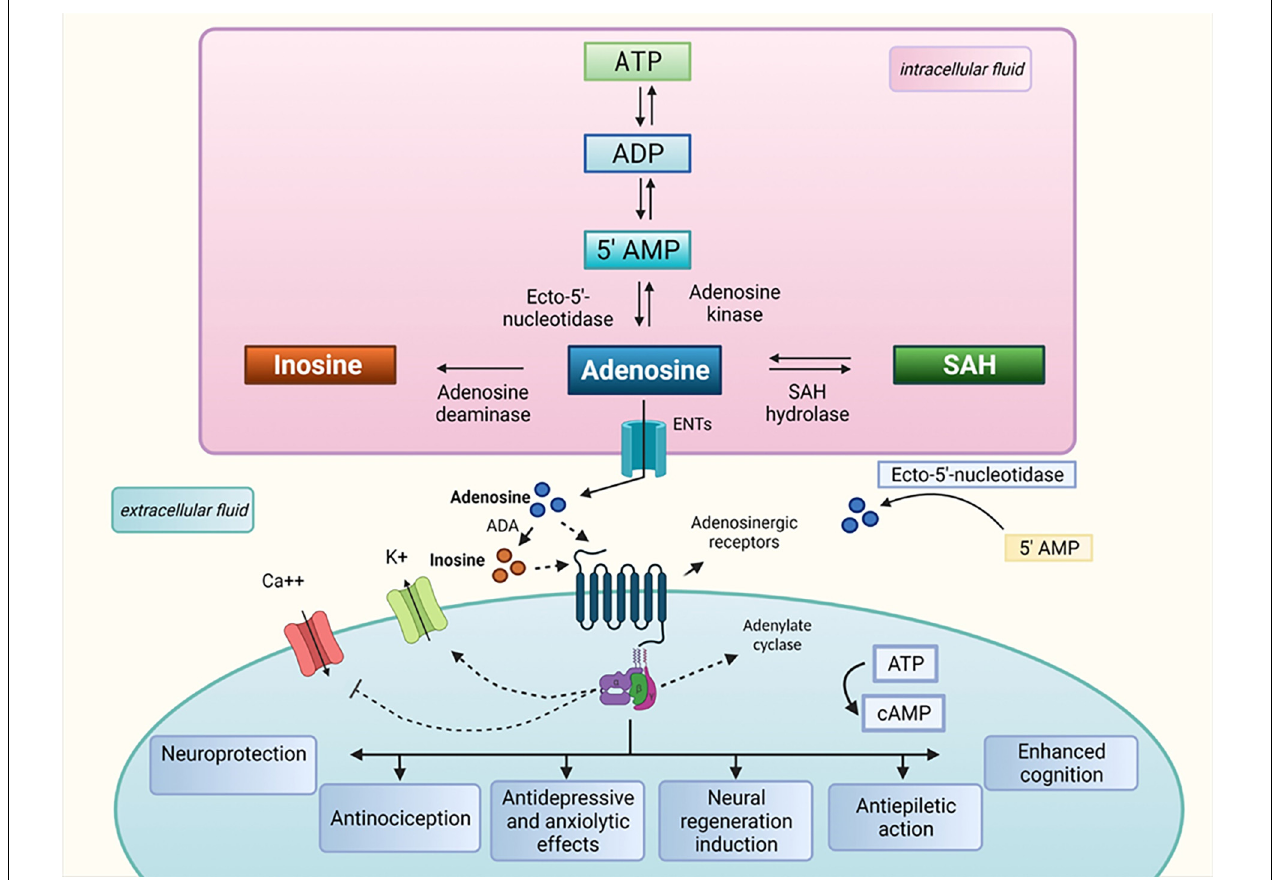
FIGURE 1 | Inosine metabolism and proposed therapeutic properties. ATP, adenosine triphosphate; ADP, adenosine diphosphate; ADA, adenosine deaminase; AMP, adenosine monophosphate; Ca++, calcium; cAMP, cyclic adenosine monophosphate; ENTs, equilibrative nucleoside transporters; K+, potassium; SAH, S